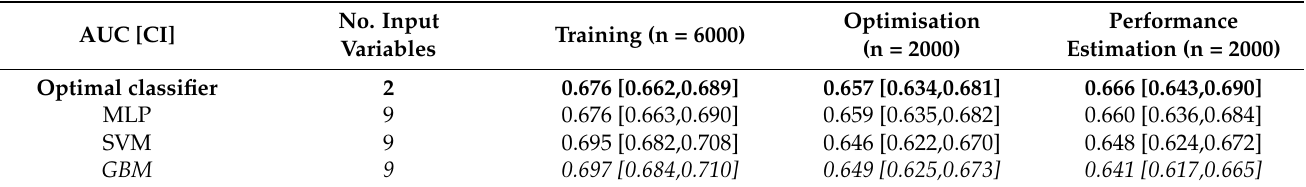
Table 1. Classification performance for the 2D circle measured by the AUC [CI]. The input variables x 1 and x 2 are ideally selected solely for their univariate